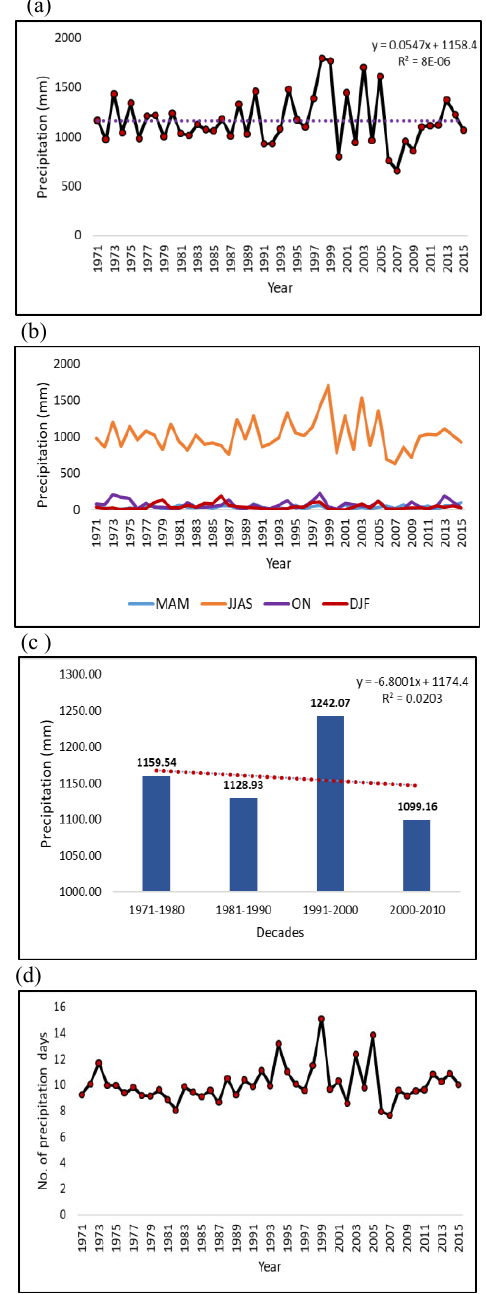
Fig 3. Precipitation trends from 1971-2015 (a) Annual precipitation (b) Seasonal precipitation (c ) Decadal trend (d) Precipitation